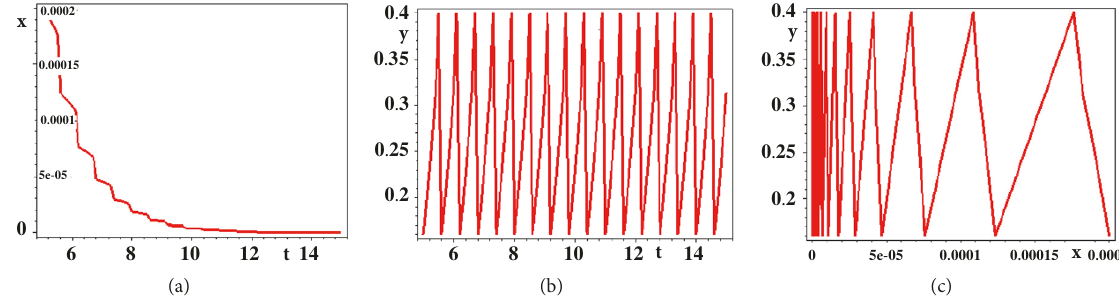
Figure 4: Time series and phase portrait of the semitrivial periodic solution of system (6) with the parameters 𝐴 = 5 , 𝑞 = 0.3 , 𝐵 = 3.5 , = 0.3 , 𝐸 = 0.6. 𝐻 = 0.4 , 𝐸 1 2